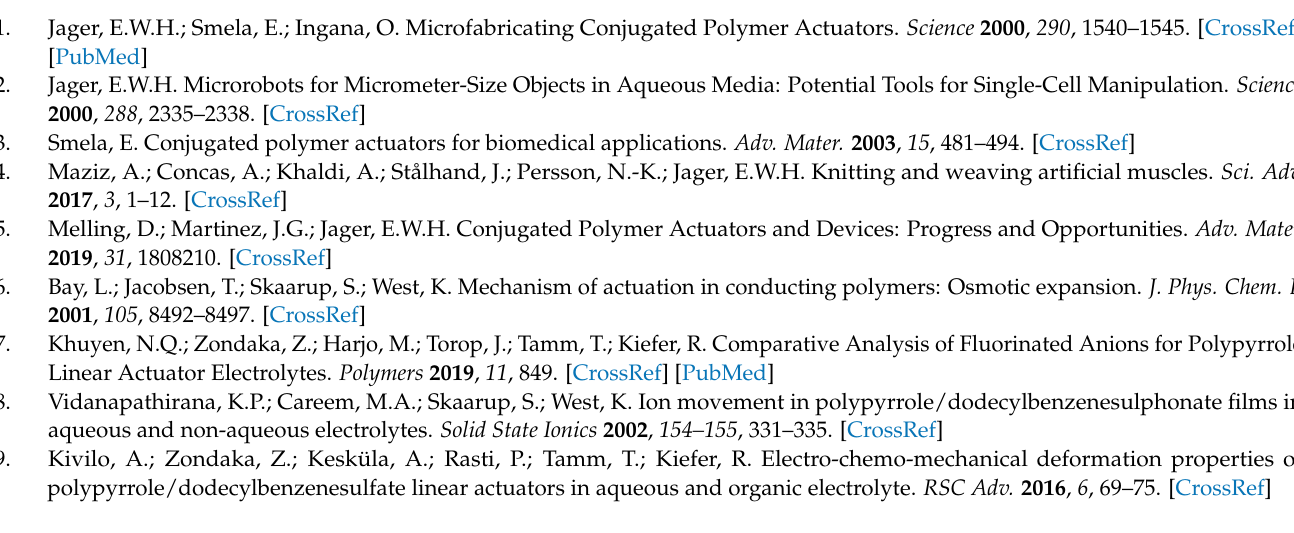
Figure 5. Square potential steps at applied frequency 0.0025 Hz (two subsequent cycles 3rd − 4th) in potential range 1.0 V to − 0.55 V (E, dashed line) in electrolytes EDMICF 3 SO 3 -PC (black curve), NaClO 4 -PC (red curve) and TBAPF 6 -PC (blue curve) showing strain of ( a ) PPy-PEO and ( b ) PPy/DBS films. The strain against charge densities in electrolytes EDMICF 3 SO 3 ( ■ ), NaClO 4 ( ● ) and TBAPF 6 ( ◄ ) for ( c ) PPy-PEO and ( d ) PPy/DBS films. The dashed lines represent the linear fit shown here for orientation